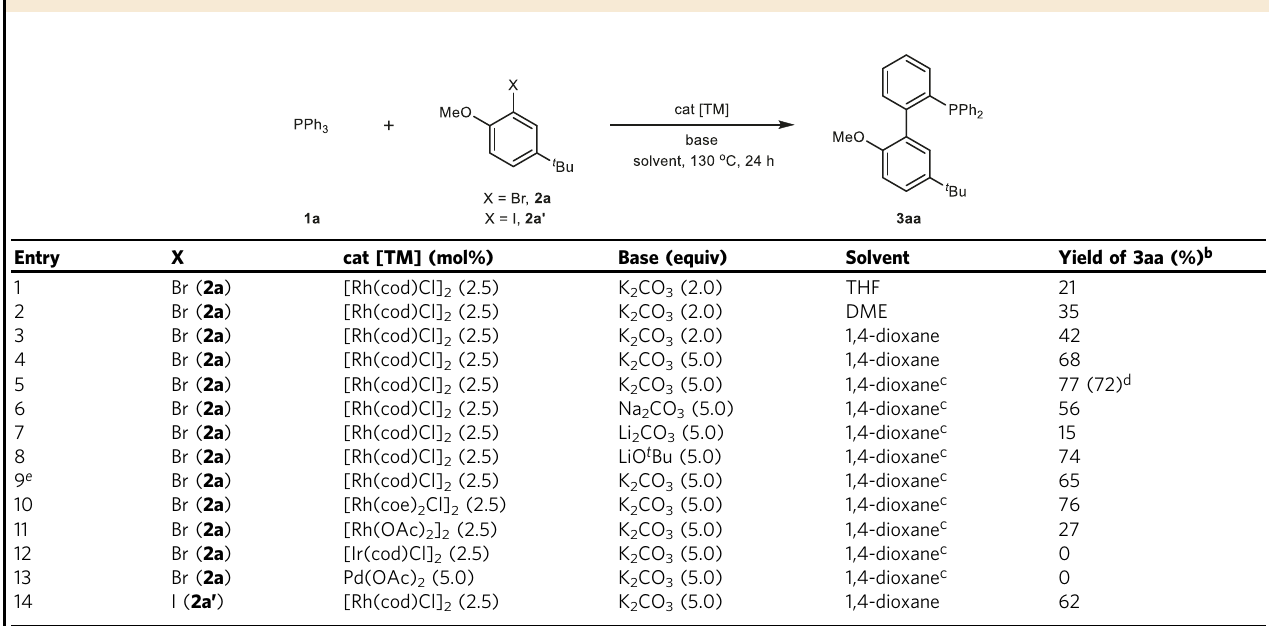
Table 1 Reaction development a